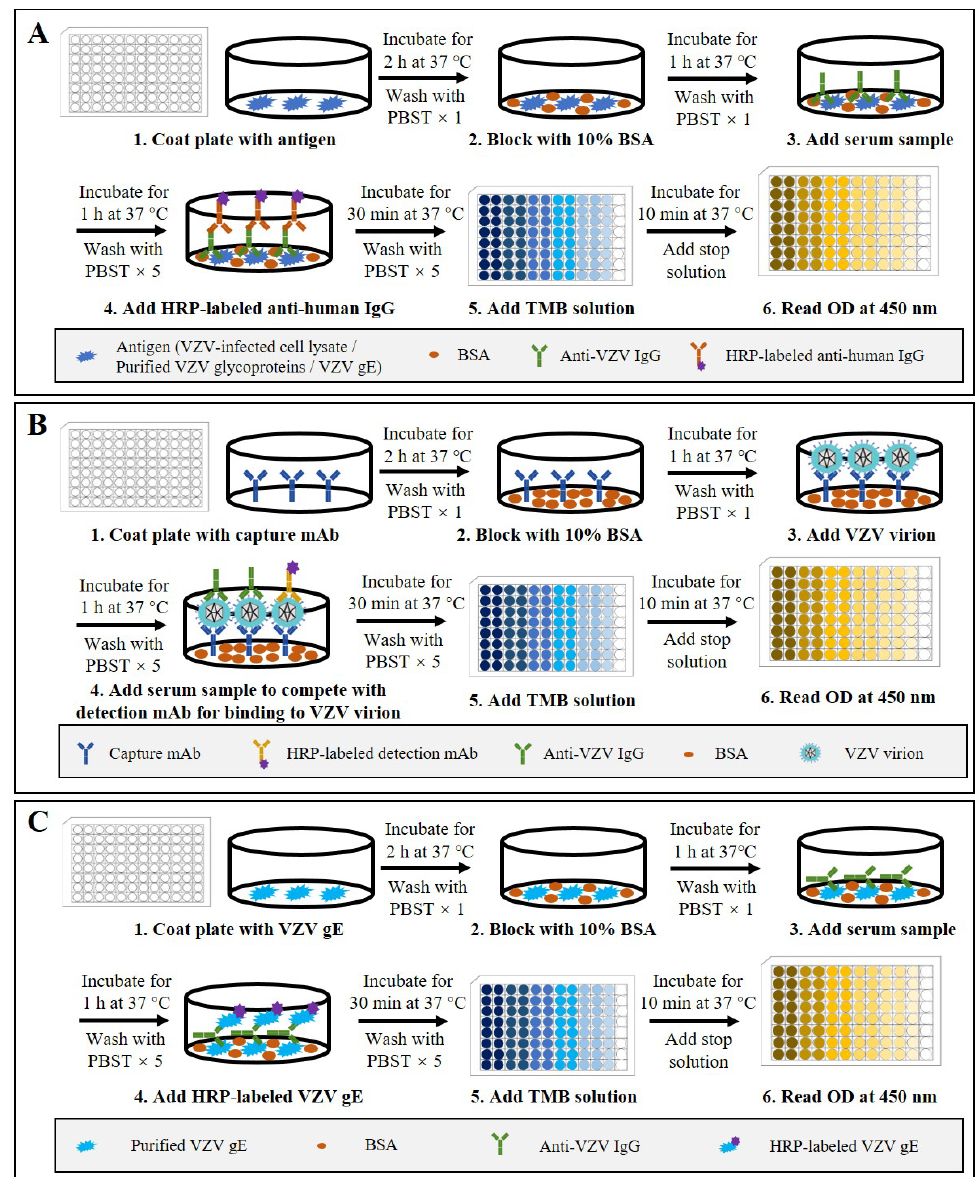
Figure 2. Schematic representation of the basic protocols for three types of ELISA that detect anti ‐ VZV antibodies. ( A ) Indirect ELISA using VZV ‐ infected cell lysate, purified VZV glycoproteins, or VZV gE as the coating antigen. ( B ) Double antibody sandwich competitive ELISA using anti ‐ ORF9 antibody as the detection antibody and HRP ‐ labeled anti ‐ gE antibody as the detection antibody. ( C ) Double gE antigen sandwich ELISA using purified VZV gE as the coating antigen and HRP ‐ labeled gE as the detection antigen.